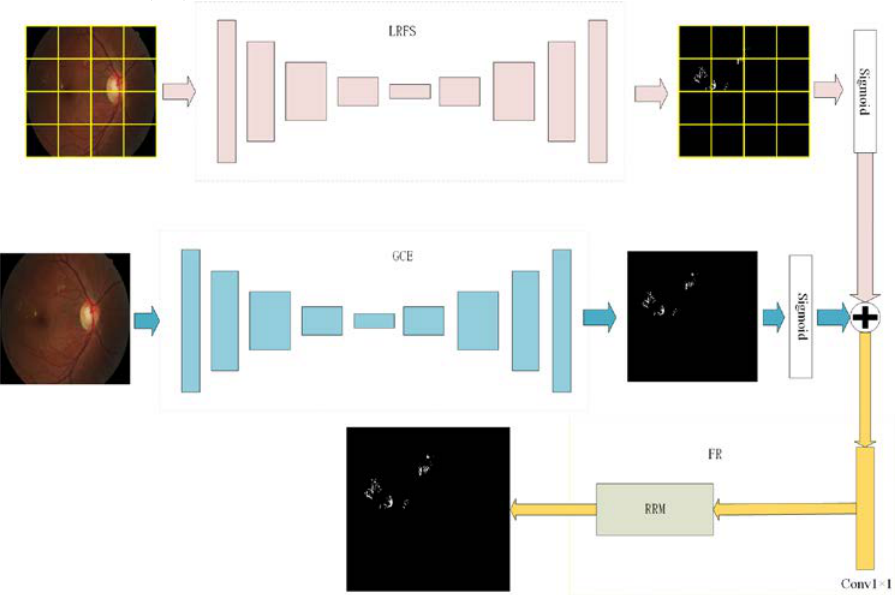
Fig. 1. Structure of